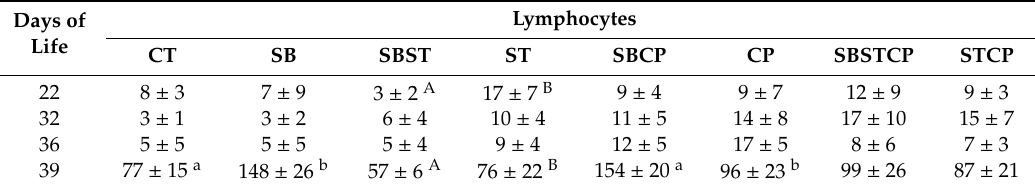
CT: control group; SB: synbiotic mix; SBST: synbiotic mix + S. typhimurium ; ST: S. typhimurium ; SBCP: synbiotic mix + C. perfringens; CP: C. perfringens ; SBSTCP: synbiotic mix + S. typhimurium + C.